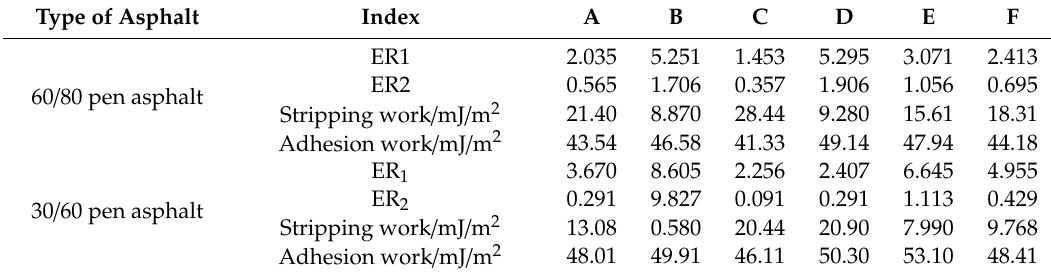
Table 11. Calculated value of adhesion evaluation index between asphalt and aggregates.